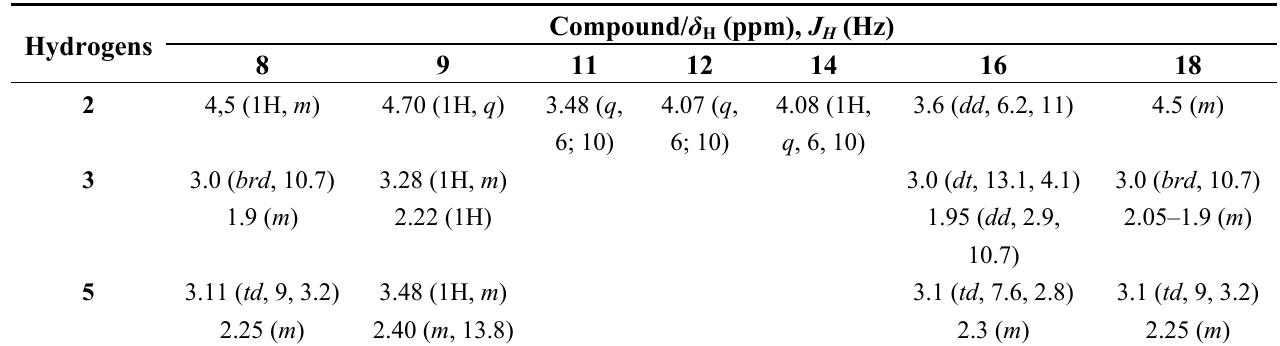
) for the plumeran indole alkaloids from Aspidosperma 3